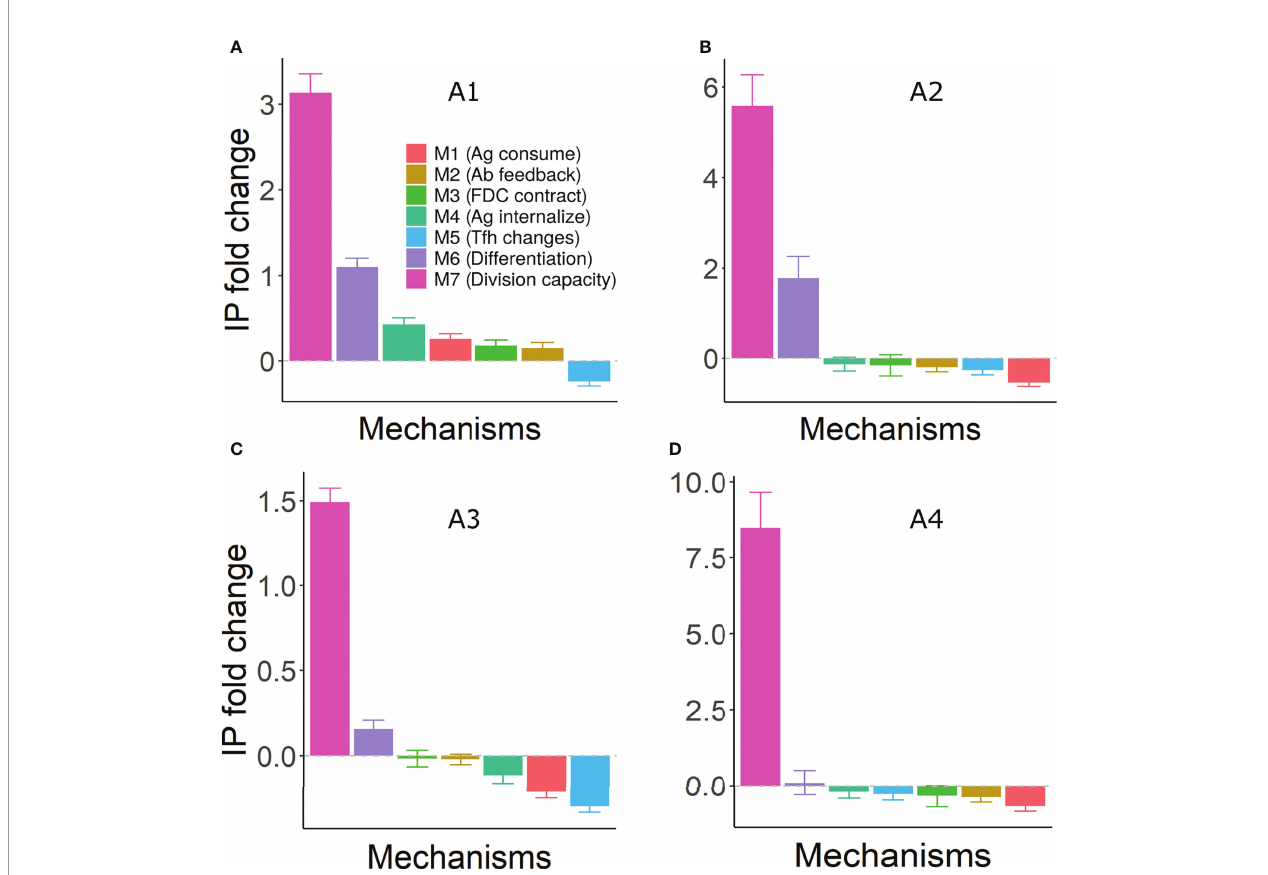
FIGURE 7 | Fold change in ef fi ciency (IP) of GC reaction under different mechanisms of shutdown. Panels (A – D) represent assumptions A1-A4, respectively. IP was calculated using equation 13 at day 21 of the GC simulation and fold change was calculated with respect to the IP of the corresponding control simulation. Error bars represent standard deviation of 50 simulations. Positive and negative values represent an increase and decrease, respectively, compared to the control simulation. Parameter values used in different mechanism: M1: 1 unit of Ag consumption per FDC-B cell interaction, M2: N =300, M3: FDC contraction rate = 0.166 µm per hour, M4: K ext =150, 200, 80 and 250 in assumptions A1-A4, M5: K T = 600, M6: k = 0.003, M7: K K = 5. GC, Germinal center; Tfh, T follicular helper cell; Ag, Antigen; Ab, Antibody; FDC, Follicular dendritic cell; IP, Immune